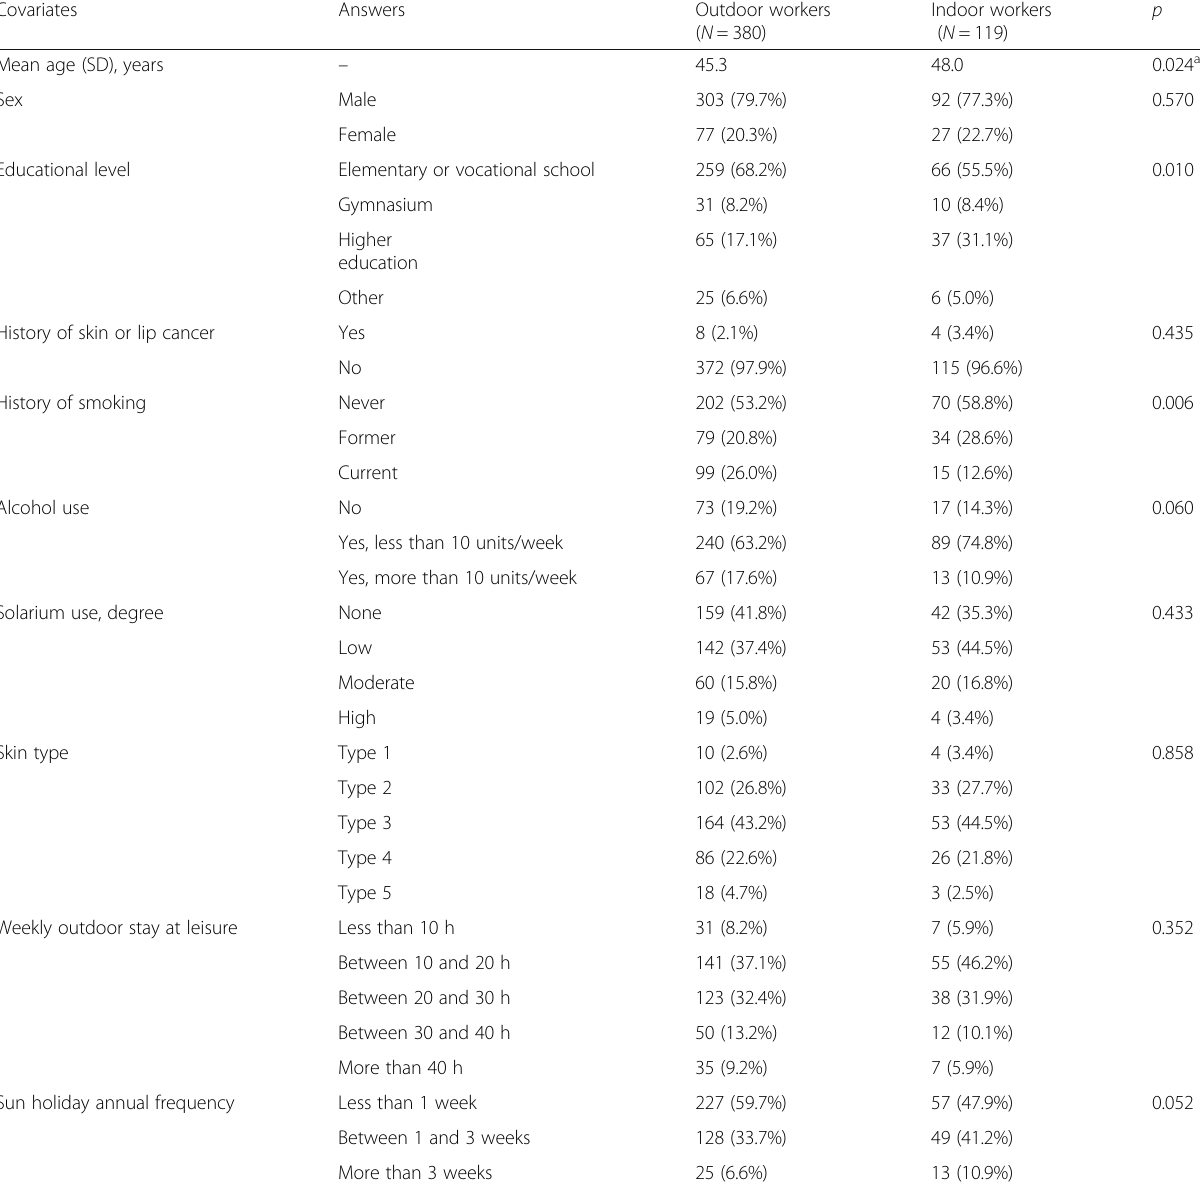
Table 1 Background characteristics for Danish outdoor and indoor worker